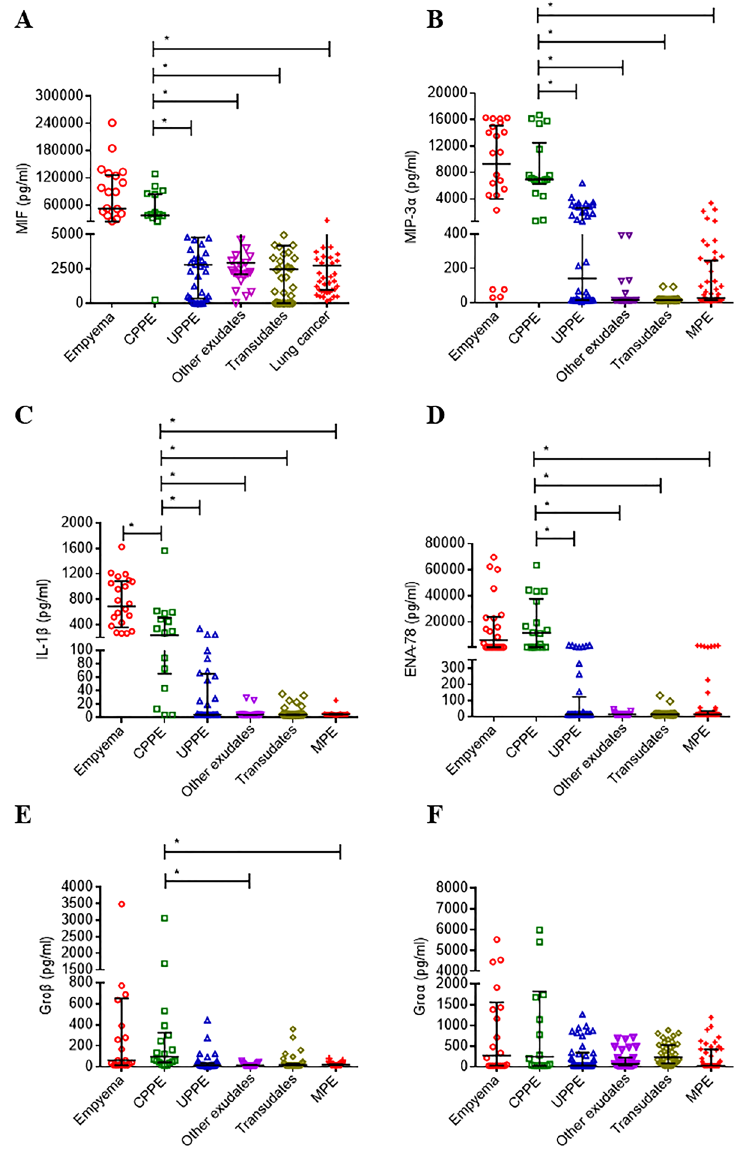
Figure 1. Pleural levels of six dysregulated cytokines in various types of pleural effusion. The pleural levels of MIF ( A ), MIP-3α ( B ), IL-1β ( C ), ENA-78 ( D ), Groβ ( E ), and Groα ( F ) were measured by ELISA in patients with empyema, complicated parapneumonic effusion (CPPE), uncomplicated parapneumonic effusion (UPPE), other exudates, transudates, and malignant pleural effusion (MPE). The middle lines represent median values. The interval lines represent the 25th and 75th percentile. Statistical analysis was done using the post hoc Tukey test. Bonferroni-adjusted p values < 0.05/30 (6 cytokines and 5 comparisons) = 0.00166 indicate